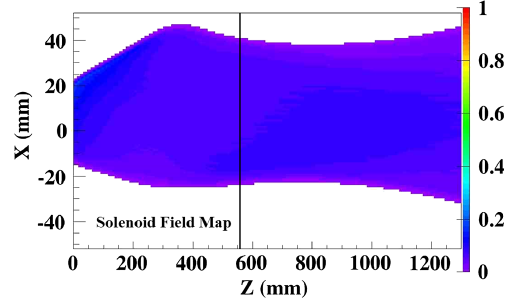
FIG. 13. Beam envelope at t ¼ 0 without secondary ion compensation, for a full beam current of 35